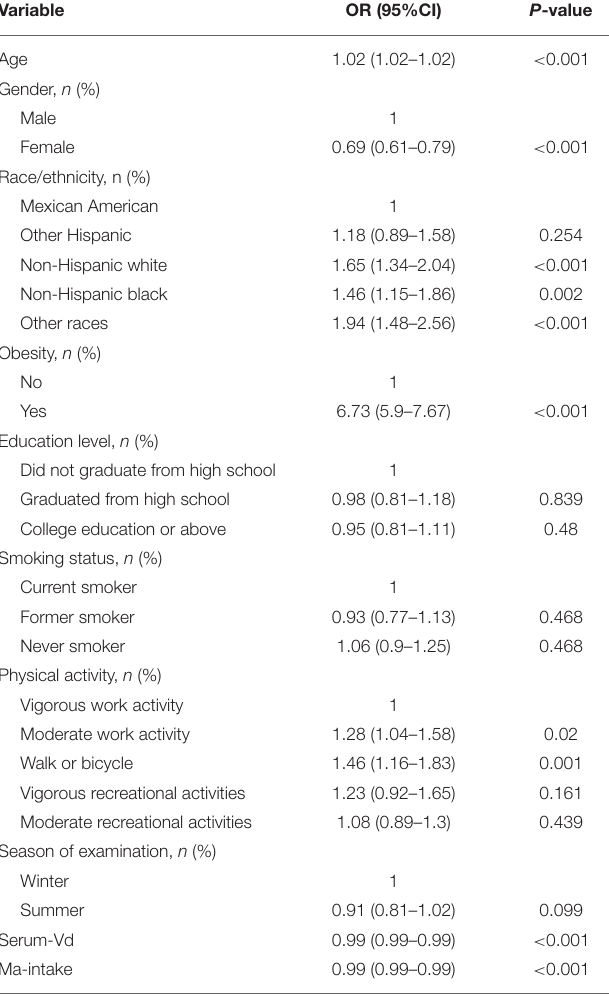
TABLE 2 | Association of covariates and impaired pancreatic β -cell function.